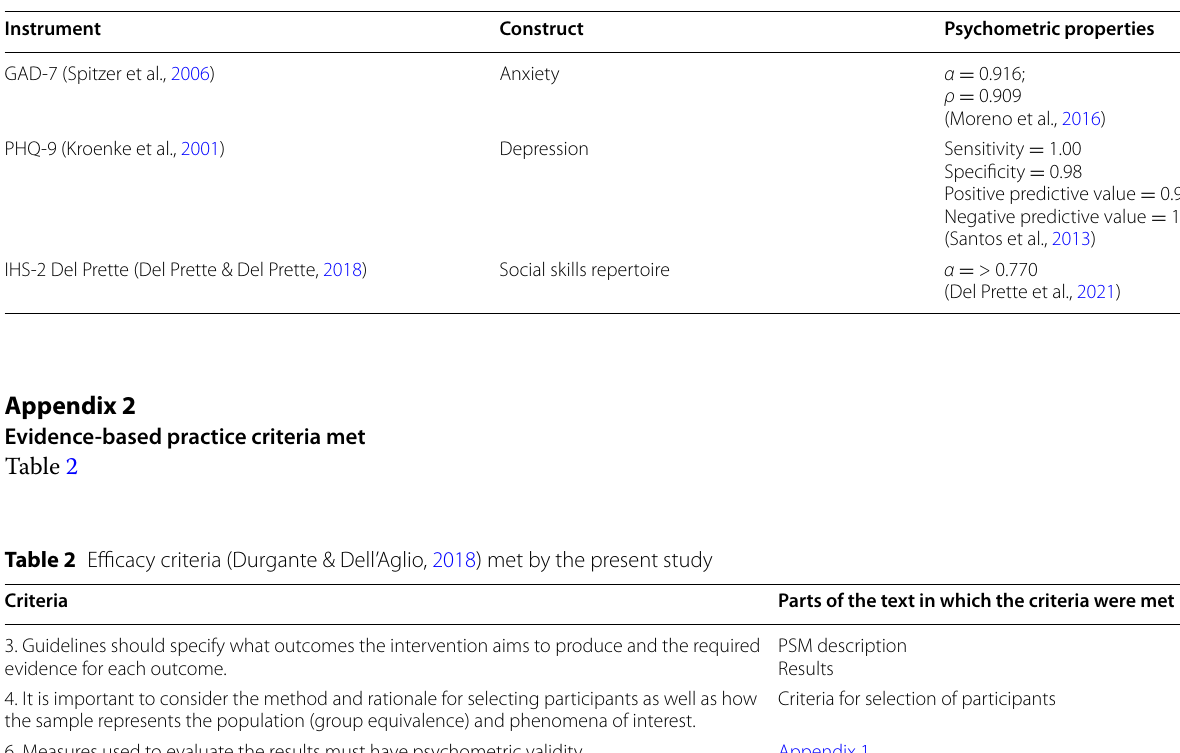
Table 2 Efficacy criteria (Durgante & Dell’Aglio, 2018) met by the present study Criteria Parts of the text in which the criteria were met 3. Guidelines should specify what outcomes the intervention aims to produce and the required evidence for each